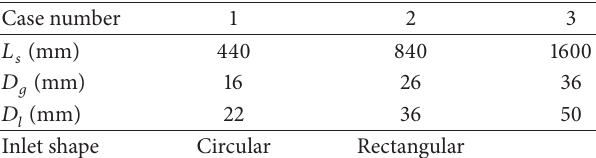
Table 1: Different parameters values for simulation